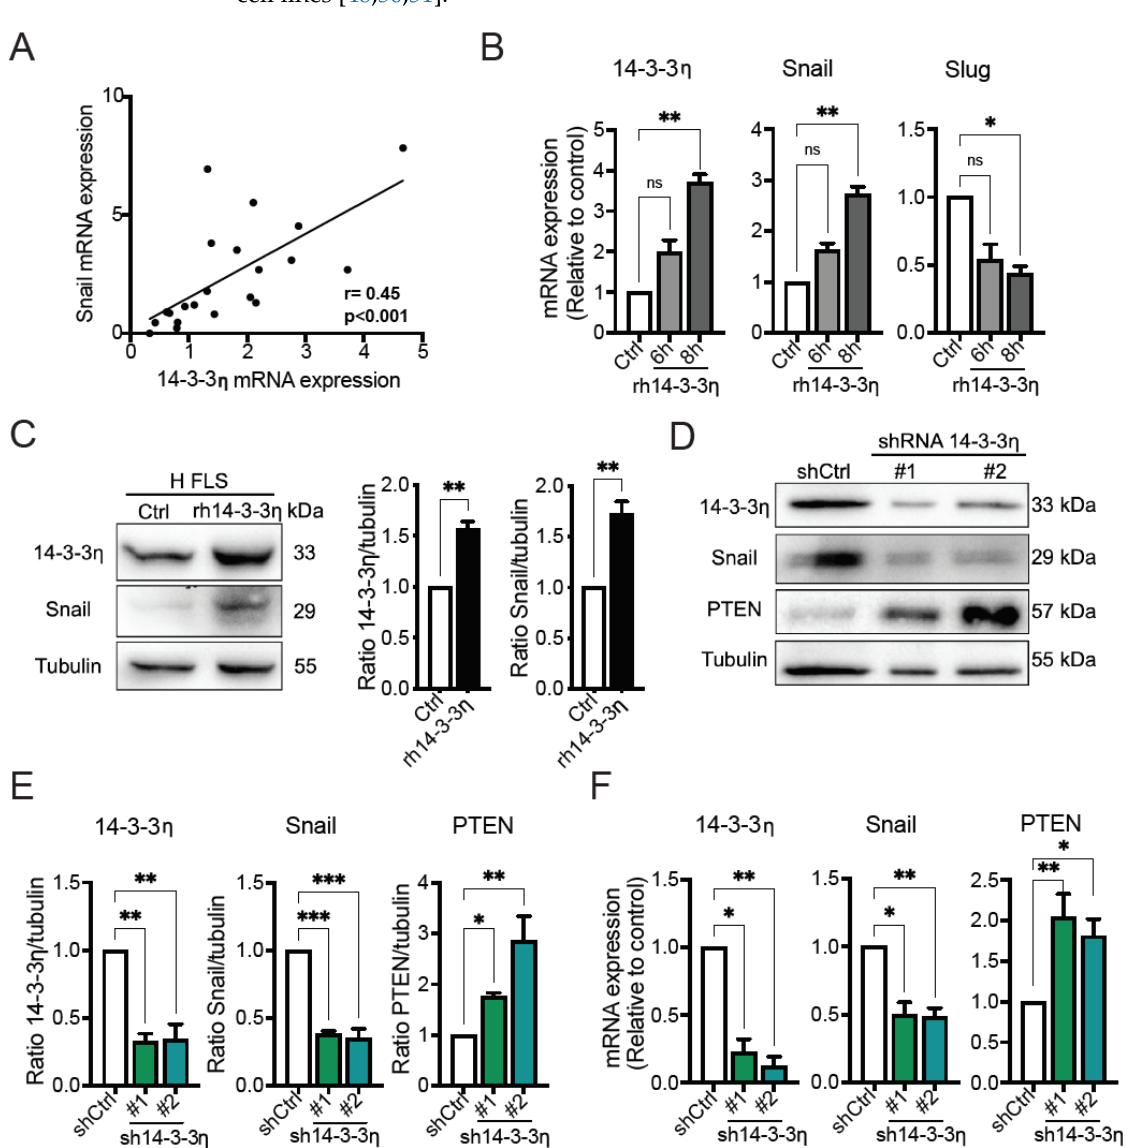
Figure 3. The role of 14-3-3η in regulating Snail expression and activity in RA FLS. ( A ) The correlation between 14-3-3η and Snail mRNA expression was measured via the Pearson’s correlation coefficient using data from different primary cultures of H FLS (n = 8) and RA FLS (n = 13). ( B ) H FLS were serum starved and treated with 50 ng/mL of rh14-3-3η for 6 or 8 h for RT-qPCR or ( C ) 48 h for Western blotting. Cell lysates were analyzed for the expression levels of 14-3-3η and Snail (n ≥ 3). Quantification of the Western blot data is presented in the right panel. ( D – F ) RA FLS were transduced with control or 14-3-3η targeting shRNAs. ( D , E ) Western blot and ( F ) RT-qPCR for the expression of 14-3-3η, Snail, and PTEN were performed. The associated graphs represent the quantification of the data ( n = 3–5). Data represent the mean ± SEM, n ≥ 3. * p < 0.05, ** p < 0.01, and *** p < 0.001, ns= non-significant, one-way ANOVA or unpaired t test.